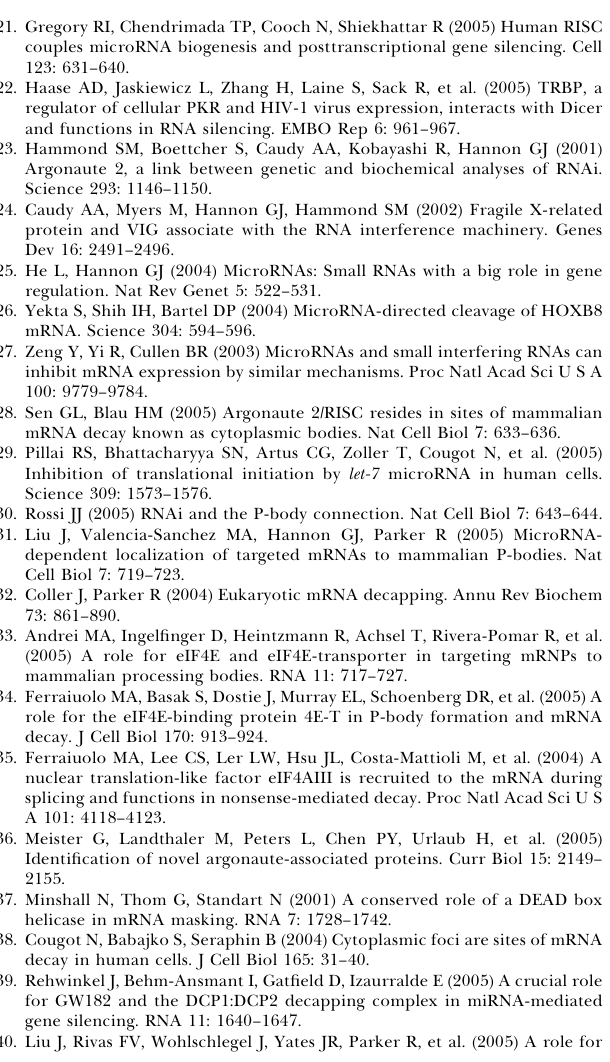
Figure S1. Subcellular Localization of Endogenous Ago2 in HeLa Cells HeLa cells were analyzed by immunofluorescence using antibodies against endogenous Ago2 (A) and Lsm1 (B), and stained with Hoechest 33258 to visualize the nucleus. The images were digitally merged to indicate co-localization of Ago2 and Lsm1 (C). Arrows point to P-bodies. Figure S2. Specific Depletion of RCK/p54 in HeLa Cells by RNAi (A) Specific knockdown of RCK/p54 in HeLa cells. HeLa cells were transfected with 50 nM siRNA against RCK/p54, harvested at 24, 48, and 72 h post-transfection, and TCEs were prepared. Analysis by immunoblot shows the specific knockdown of RCK/p54 protein without changing the protein levels of Lsm1 or Ago2. (B) Specific depletion of RCK/p54 mRNA after siRNA treatment. Total RNA samples (3 l g) from HeLa cells transfected with siRNA against RCK/p54 were reverse-transcribed and analyzed by quantita- tive PCR to quantify mRNA levels. RCK/p54 mRNA levels were normalized to GAPDH mRNA and are presented relative to mock treatment. Data are from two representative, independent experi- ments. Figure S3. Let -7 Inhibition Does Not Affect RAS mRNA Levels Total RNA samples (3 l g) from HeLa cells transfected with 100 nM